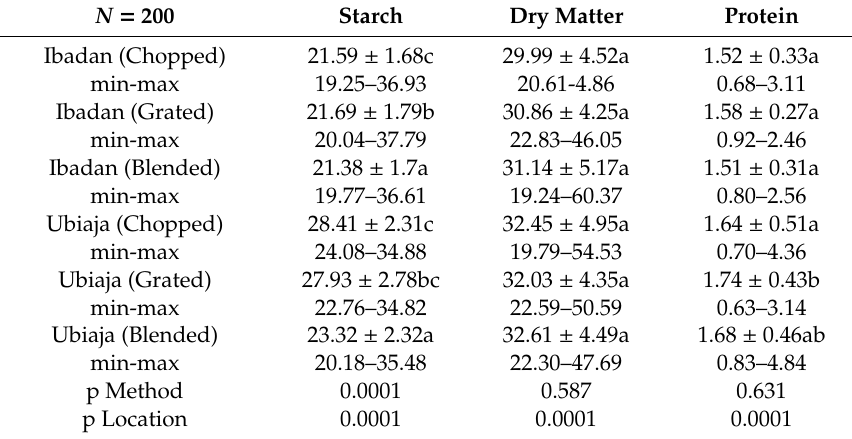
Table 2. Showing Starch, Dry matter, and Protein content (%) of Yam ( D alata ). N =